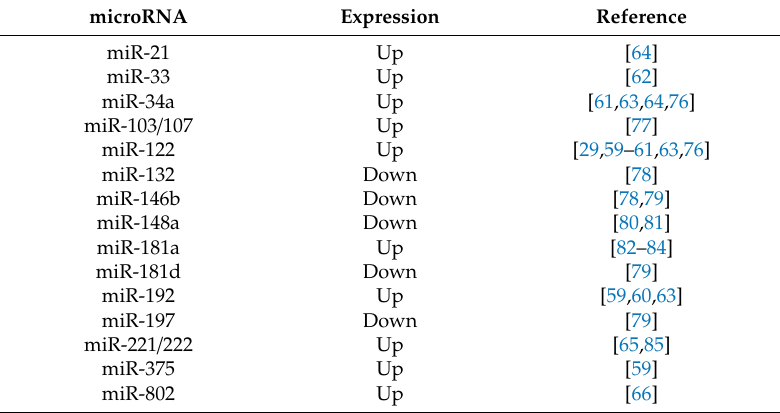
Table 2. MiRs Implicated in Liver Diseases.